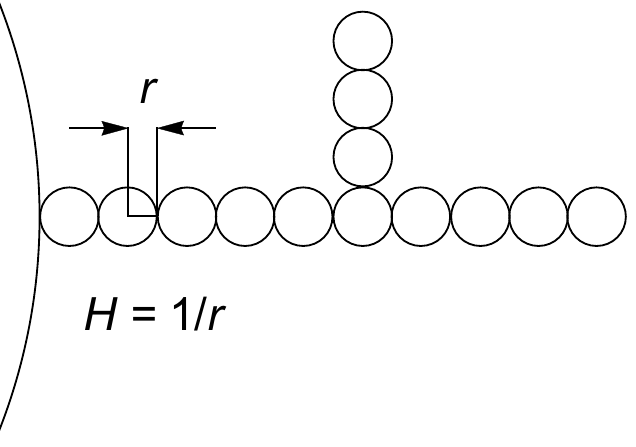
Figure 15. Growth of necklace-like protrusions as aggregates of isotropic curved membrane nan- odomains is energetically favorable when critical concentration ˜ x c of nanodomains is